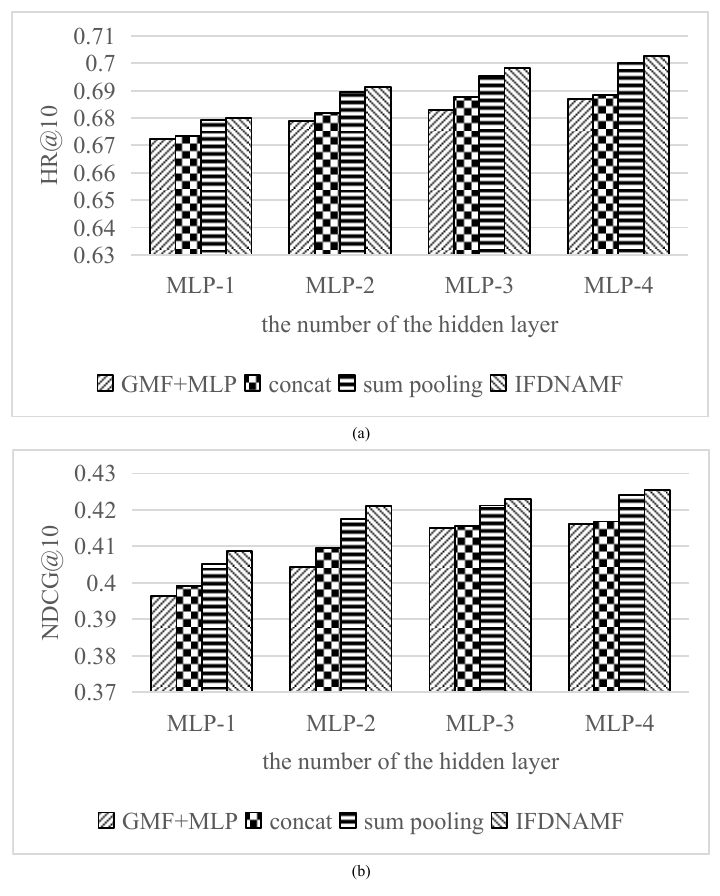
Figure 5. The HR@10 and NDCG@10 of models with different layers on Book-crossing. ( a ) HR@10. ( b )